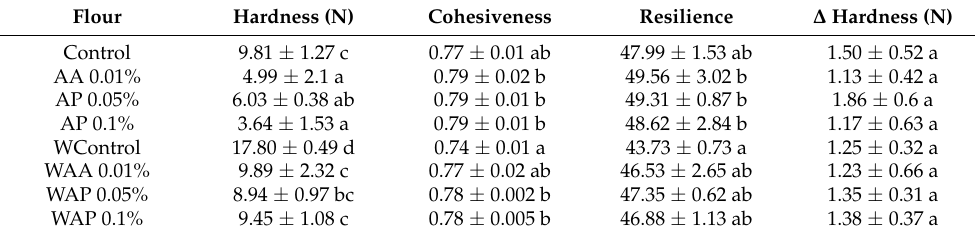
Table 3. Textural properties of